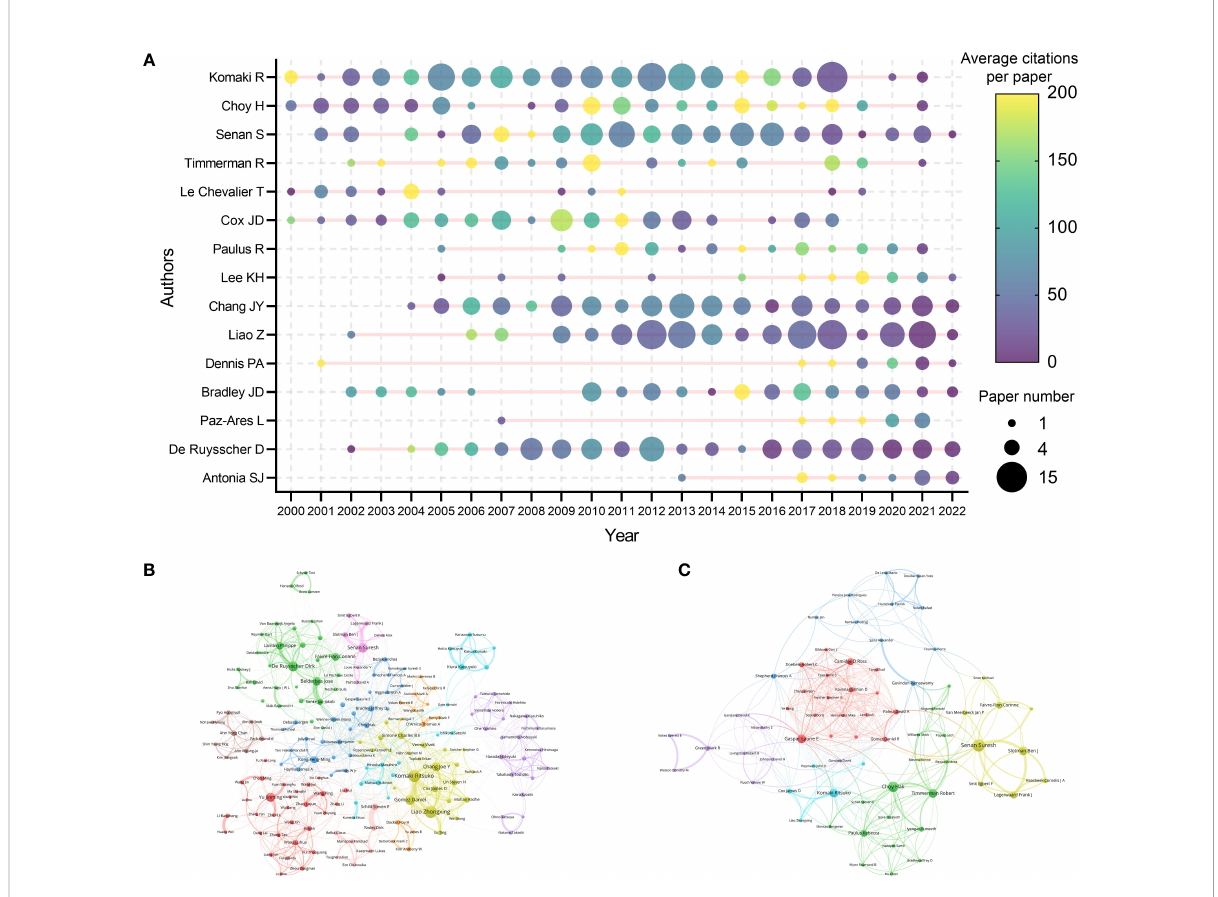
FIGURE 5 (A) The top-15 cited authors ’ production and citation over time. The node size represents the paper number and the color represents the average citations per paper. (B) Network visualization of authors with at least 20 papers related to lung cancer radiotherapy. (C) Network visualization of authors with at least 2 top-papers related to lung cancer radiotherapy. The circle size represents the number of papers. The breadth of the curves represents the connection strength. The authors in the same color have stronger collaboration with each